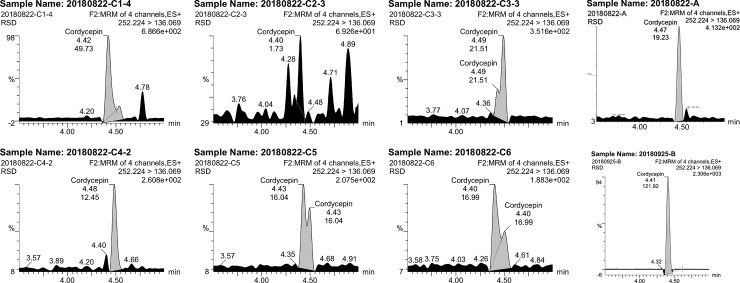
Cordycepin contents in different samples.